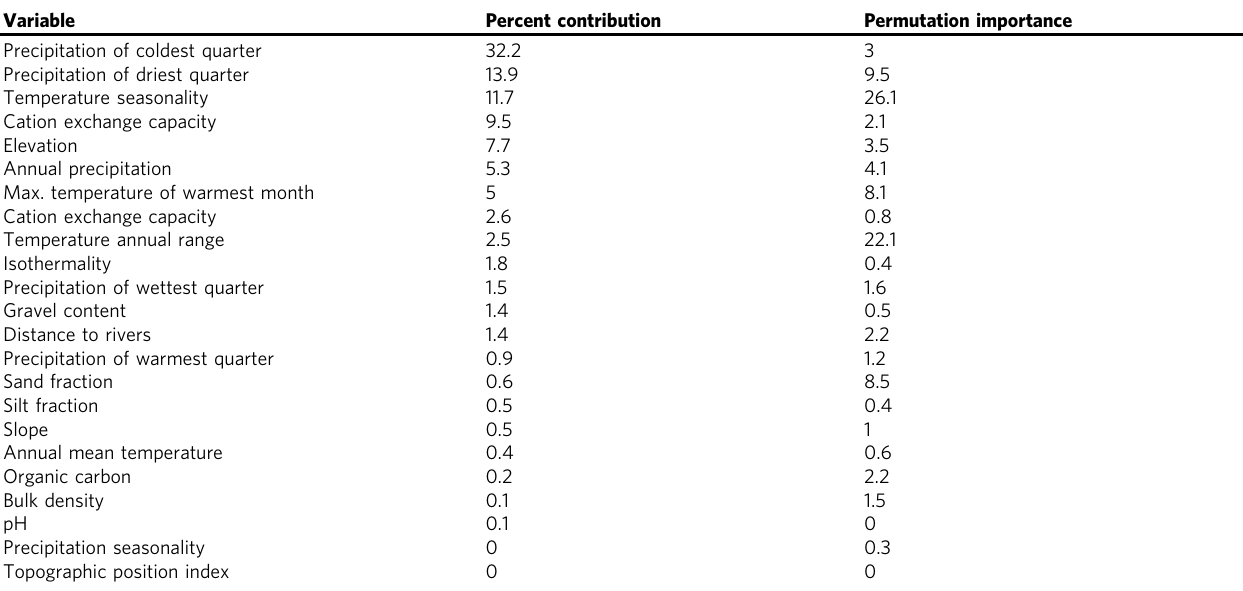
Table 2 Percent contribution and permutation importance of the bioclimatic, edaphic and terrain variables included in the fi nal MaxEnt model